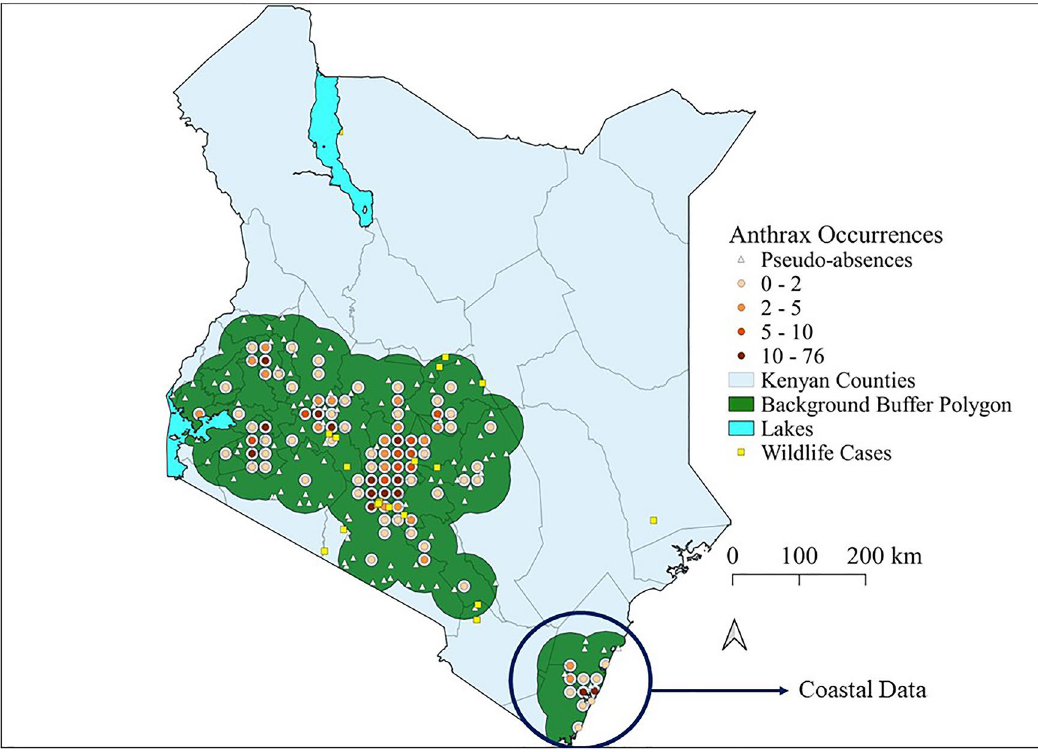
Figure 3. Spatial distribution of thinned livestock anthrax case locations across Kenya from 2006 to 2020. The map shows livestock anthrax case locations (n = 540) thinned to pixels of 20 km 2 to form 95 new marked locations. The orange dots show the new presence locations which are marked points with colour intensity representing the number of livestock cases per location. The white triangles show the random pseudo-absence locations. The yellow squares are the wildlife cases obtained from the Kenya Wildlife Service. The green polygon is the background calibration buffer used to derive the random pseudo-absence locations. This map was generated using Quantum Geographical Information Systems (QGIS) v. 3.16.11 (https:// www. qgis. org/ en/ site/ forus ers/ downl oad.